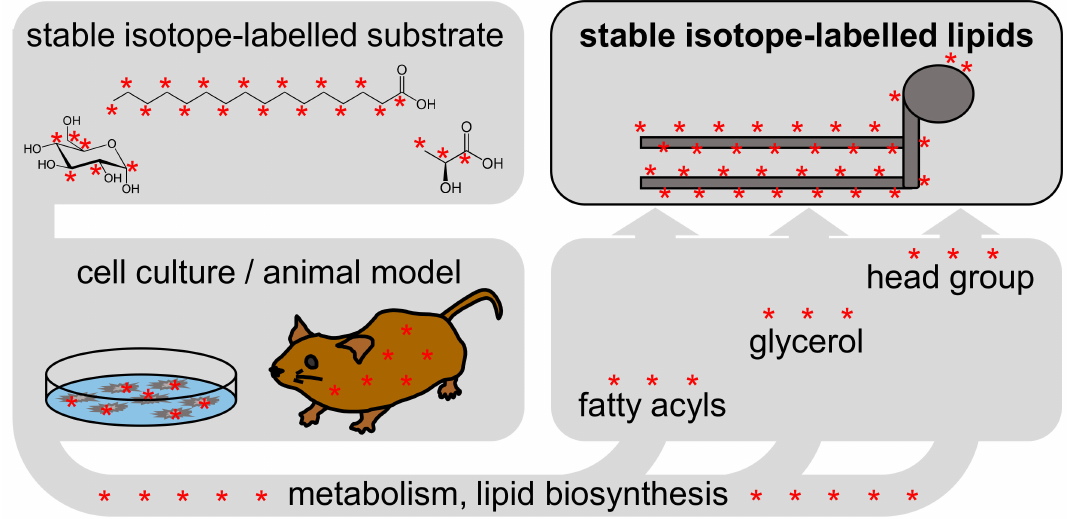
Figure 1. Stable isotope labelling workflow in biological systems. A stable isotope-labelled substrate is metabolized into the lipid building blocks (fatty acyls, glycerol and head